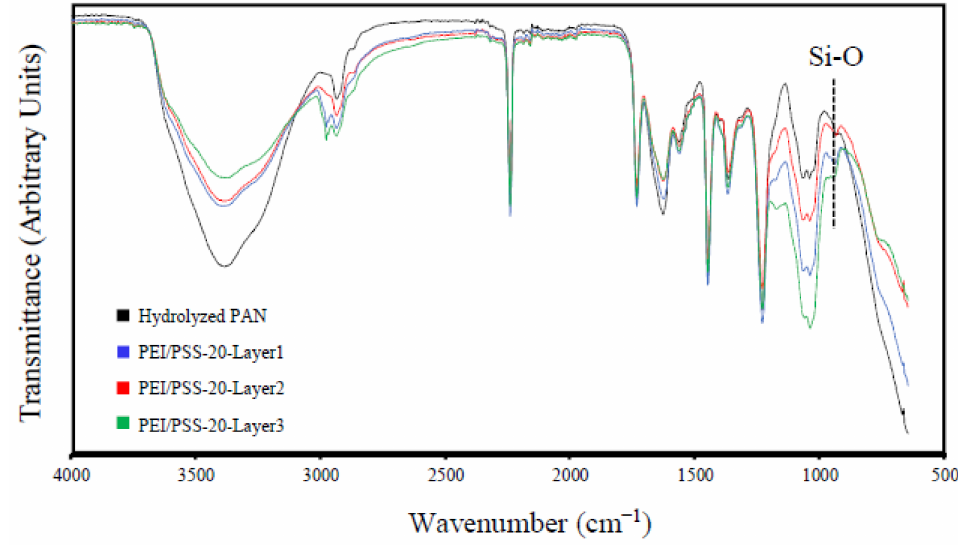
Figure 4. FTIR spectra of the hydrolyzed PAN and the PEI/PSS-CSH samples with 1, 2 and 3